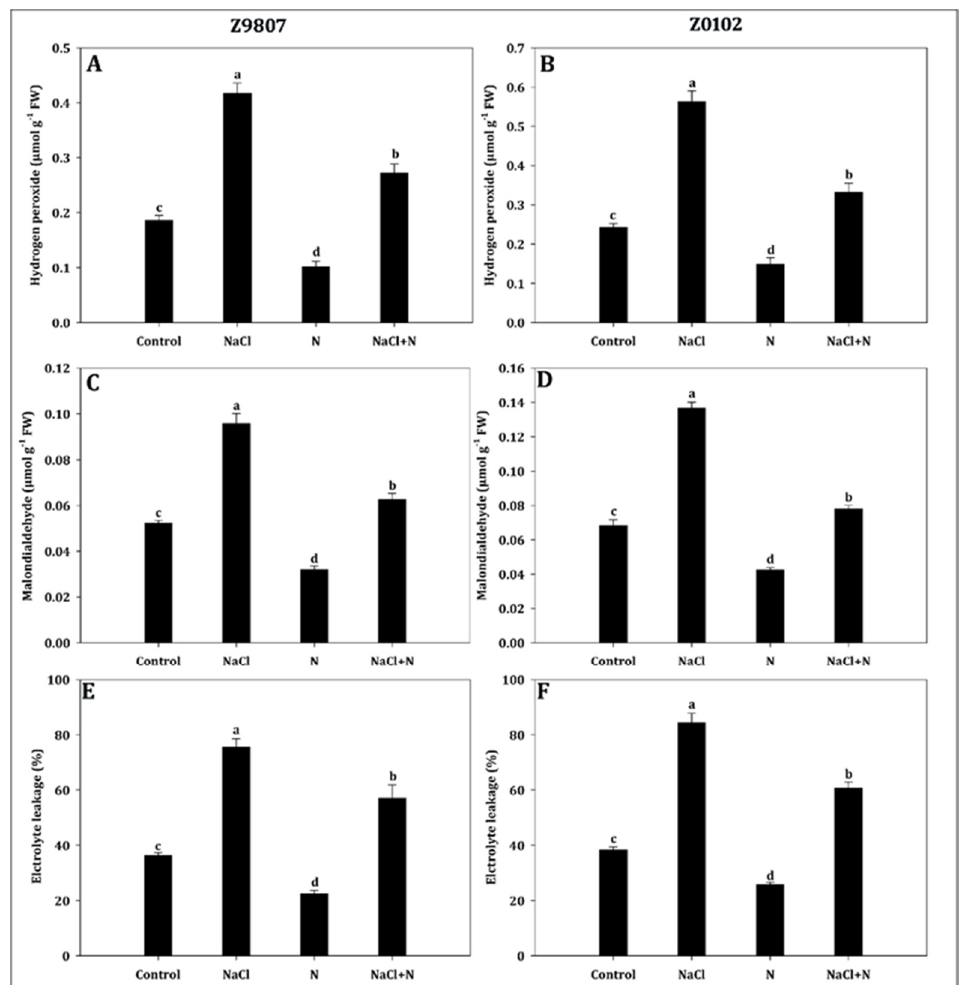
Figure 7. Effect of nitrogen supplementation on ( A , B ) hydrogen peroxide, ( C , D ) malondialdehyde, and ( E , F ) electrolyte leakage ratio in Gossypium hirsutum L. under salinity stress. Data represent the mean of three replicates and bars with different letters denote significant differences at p < 0.05.